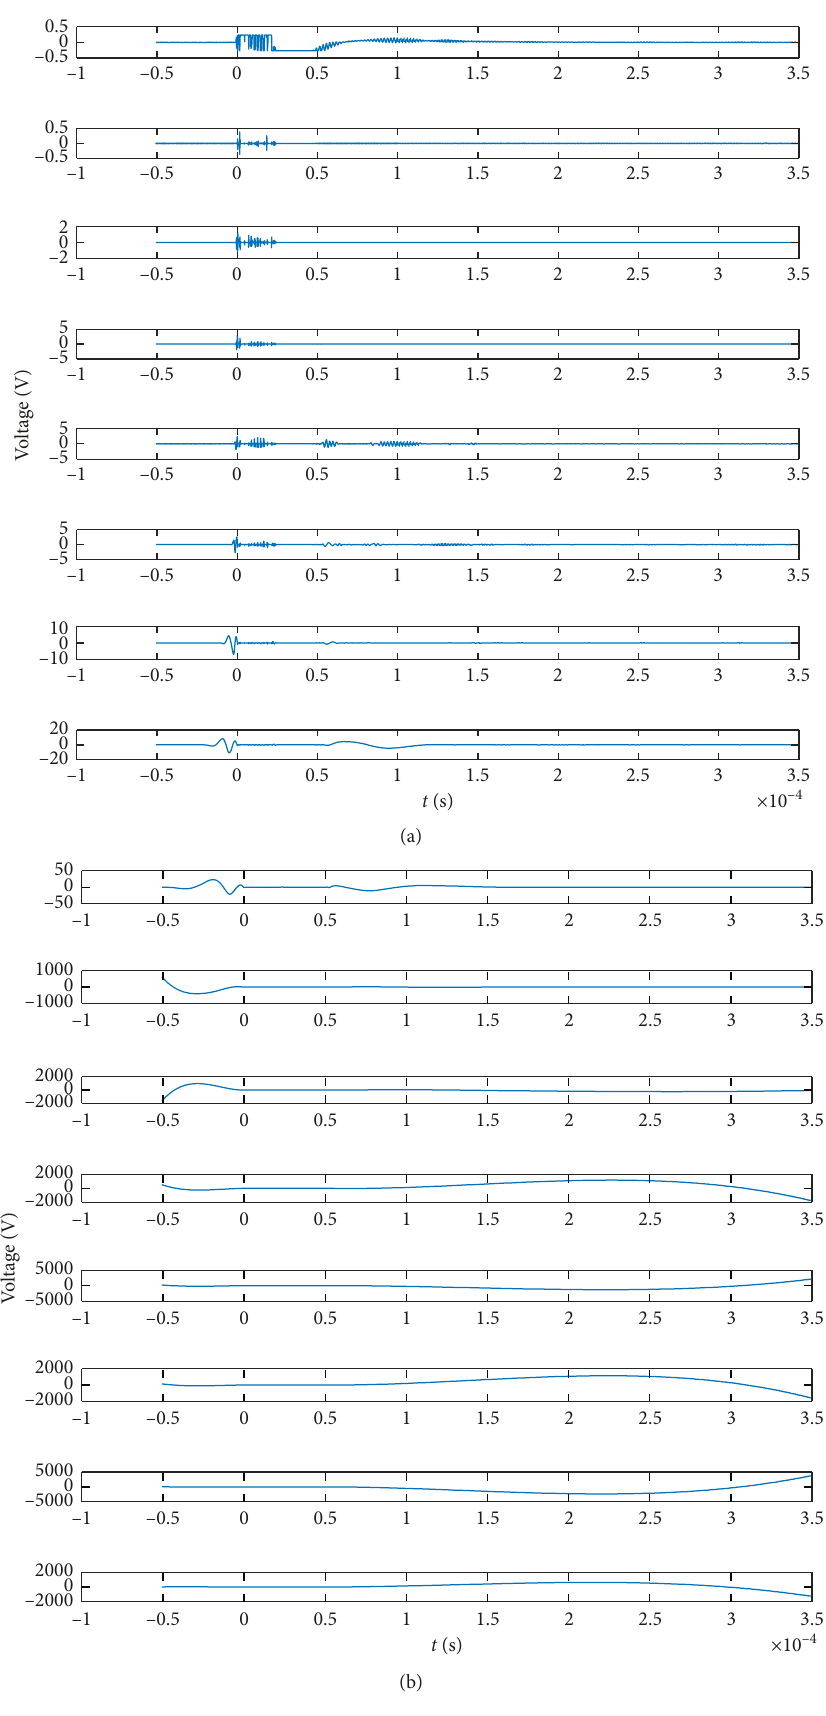
Figure 9: The IMF obtained by the improved EEMD method. (a) IMF 1–8. (b) IMF